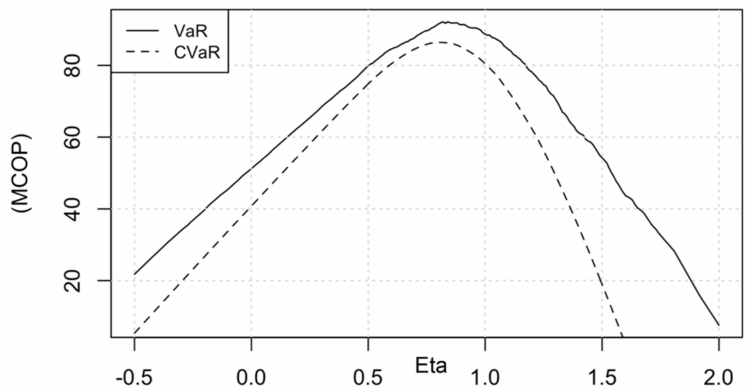
Figure 6. Sensitivity of the VaR and the CVaR to the contracting level (Eta). Simulation of the behavior of the value-at-risk (VaR) and conditional VaR (CVaR) at different contracting levels (Eta).